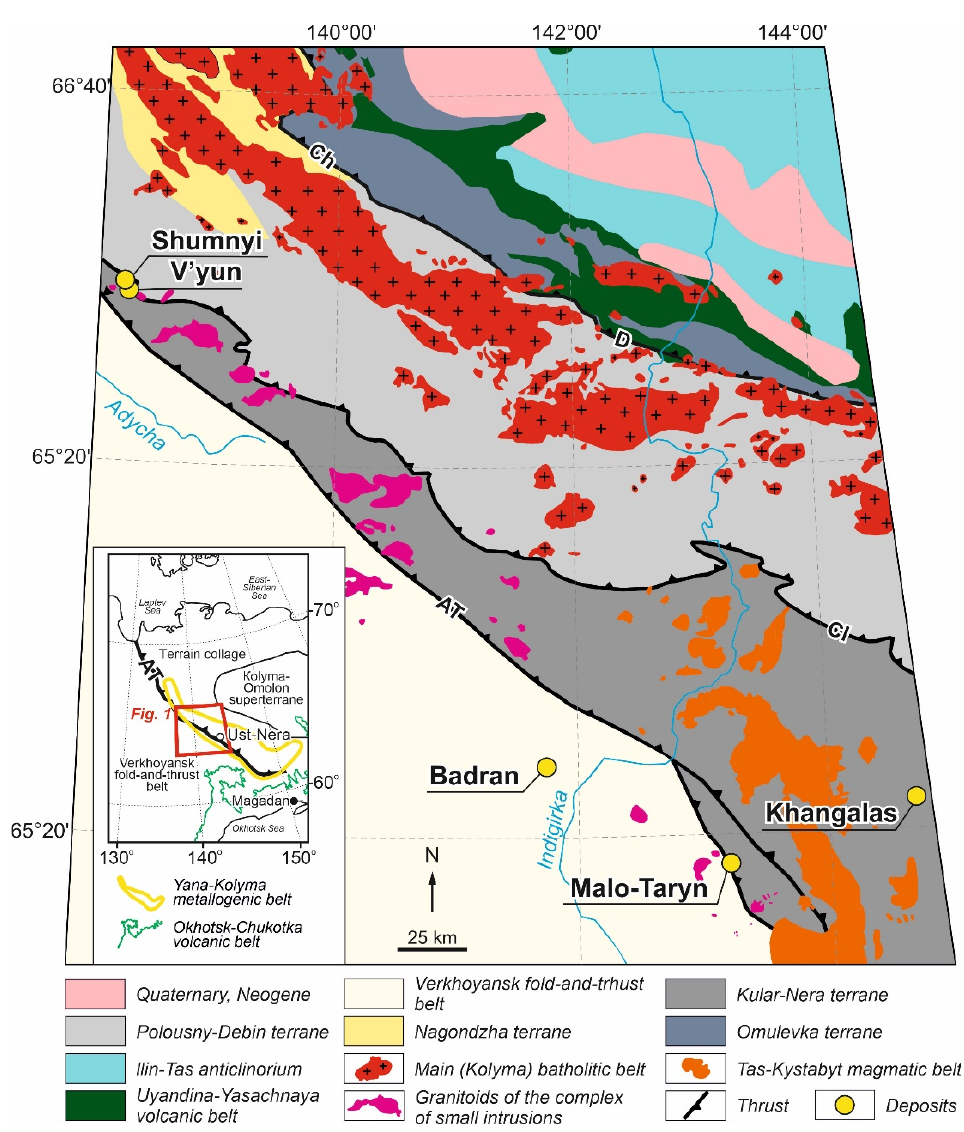
Figure 1. Geology of the central part of the Verkhoyansk–Kolyma orogen with main tectonic units, Jurassic–Cretaceous magmatism, and studied deposits. Faults: AT—Adycha–Taryn, CI—Charky– Indigirka, D—Darpir, Ch—Chibagalakh.